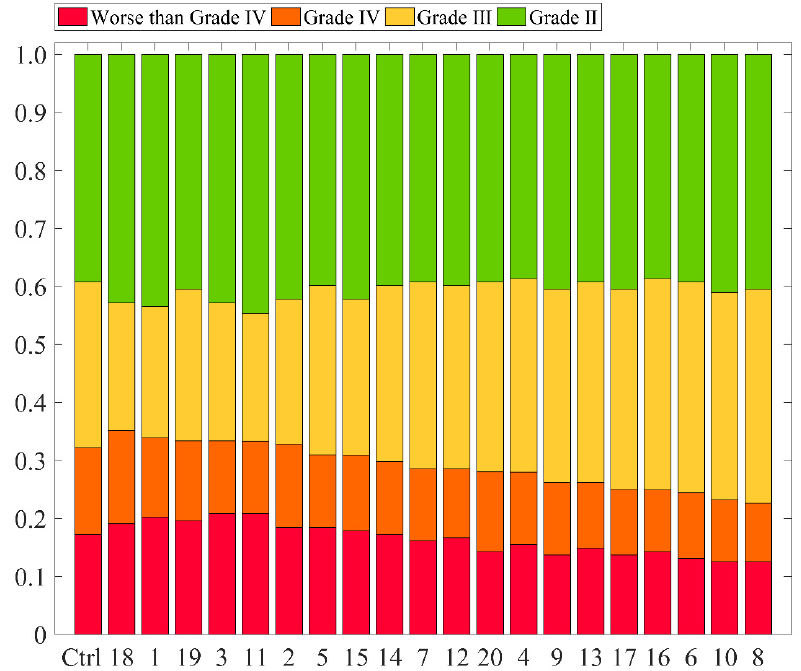
Figure 4. Bar chart of area proportion of different seawater quality in both control and 20 allocation experiments. (Worse than Grade IV (red), Grade IV (orange), Grade III (yellow) and Grade II (green)).